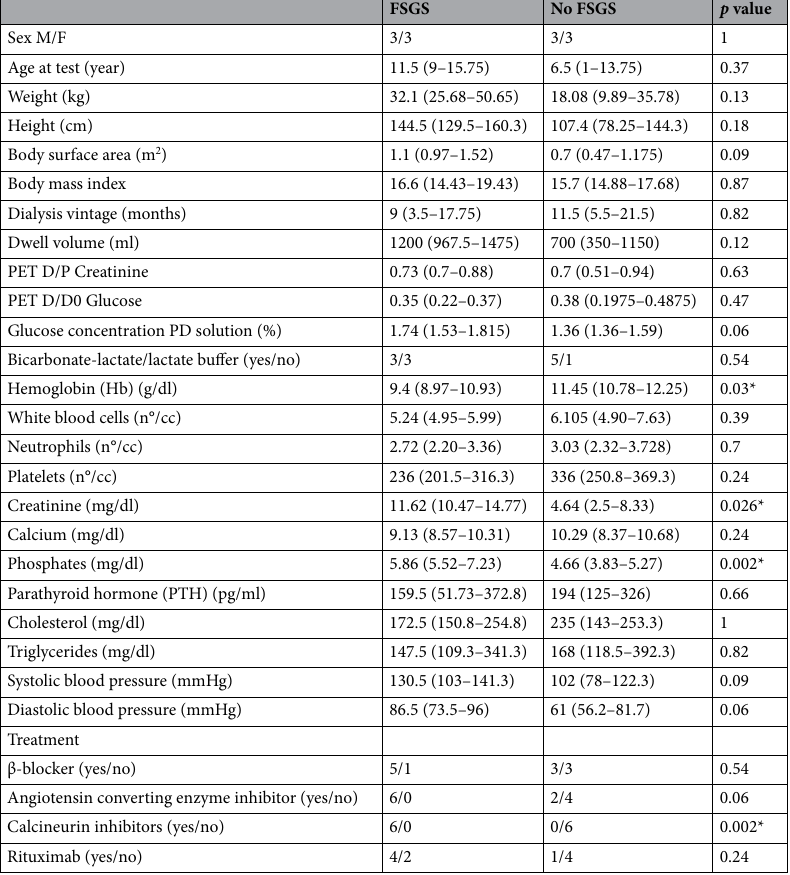
was rinsed in PBS and centrifuged again at 100,000× g for 120 min at 16 °C.The final pellet was stored at − 80 °C until use. Immuno-magnetic beads capture. The method is based on the capture of a specific subset of exosomes from peritoneal dialysis effluent using a biotinylated antibody and streptavidin magnetic beads. Enriched exosomes fractions were mixed with polyclonal biotin-conjugated anti-human mesothelin (MSLN) antibody (LifeSpan BioSciences, Seattle, WA, USA) and incubated 4 h at RT with gentle rotation. Then, strepta- vidin Dynabeads (ThermoFisher) were added according to the procedure of the manufacturer. Briefly, exosome- antibody-dynabeads complexes were incubated for 30 min at RT with gentle rotation, placed on the magnet and rinsed five times to remove unspecific exosomes and unbound antibodies.Then, sample was removed from the magnet and bound exosomes collected by adding 250 µl of elution buffer. Finally, supernatant was centrifuged at 100,000× g for 120 min at 16 °C to pellet the exosomes pelleted. Such rinse/centrifugation cycle was carried out five times to obtain a clean anti-human mesothelin-positive exosome fraction. Size and purity of the isolated exosomes were assessed by DLS.